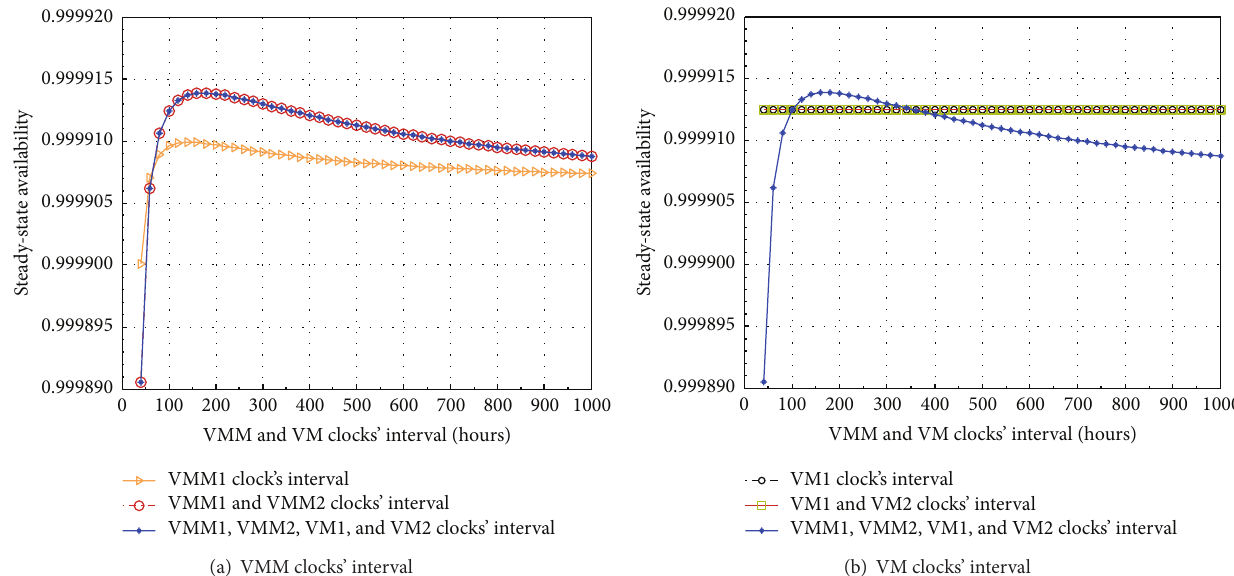
Figure 7: SSA sensitivity analysis of VMM subsystem with respect to VMM and VM clocks’